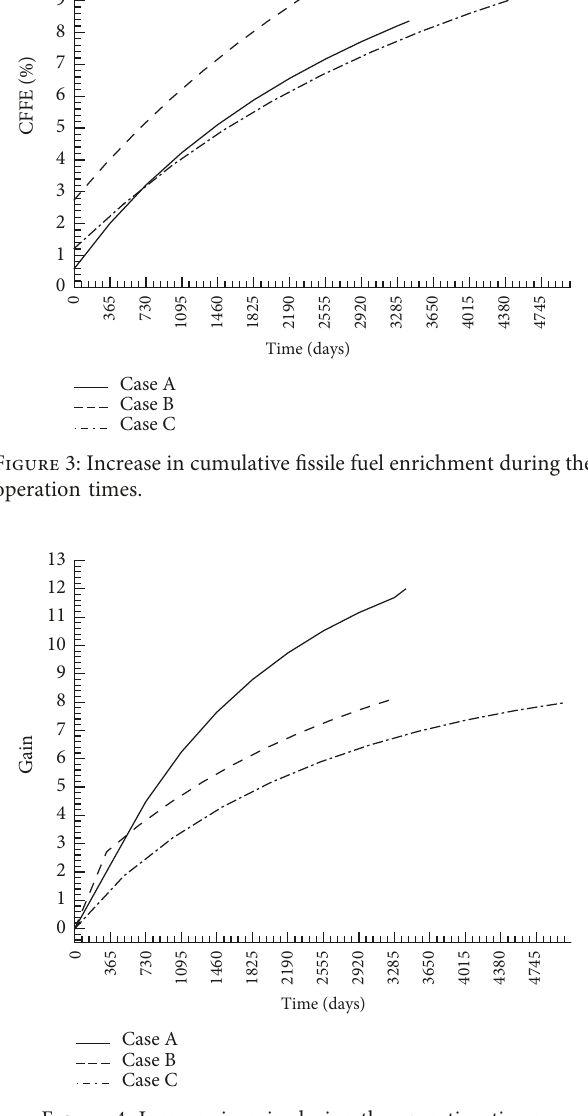
Figure 4: Increase in gain during the operation